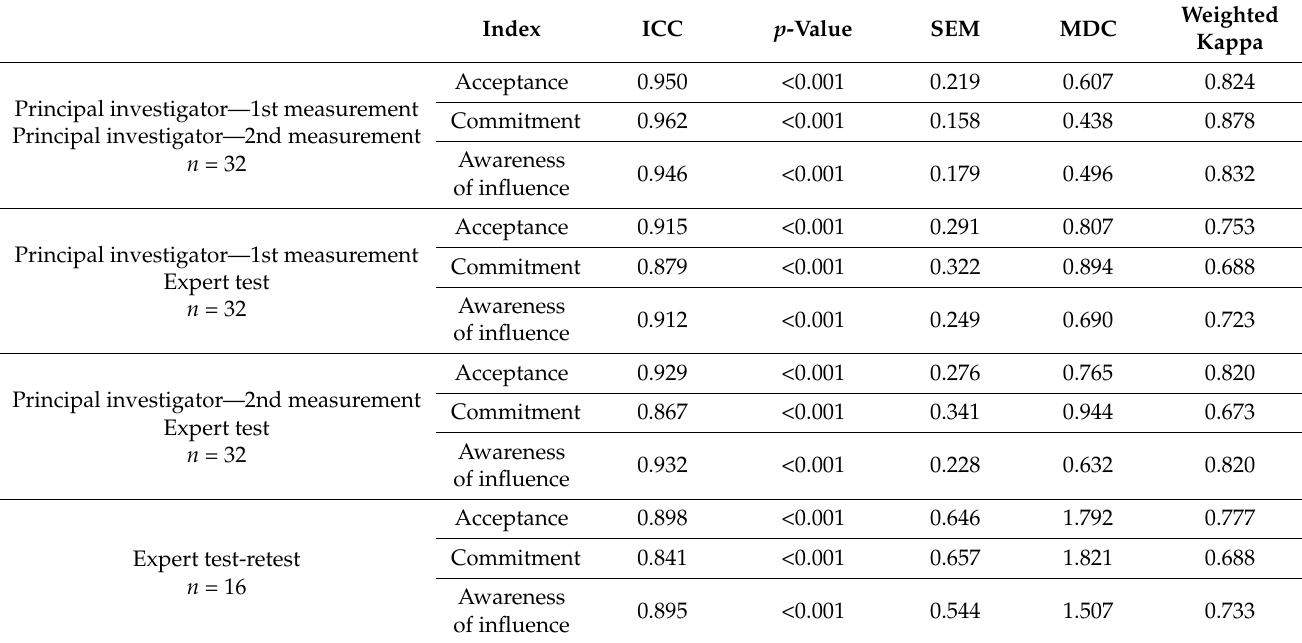
Table 3. Intra-class correlation coefficient, standard error of measurement (SEM), minimum detectable change (MDC) and significance of the evaluations carried out by the principal investigator (first and second measurements) and the expert and those obtained in the test and the retest.